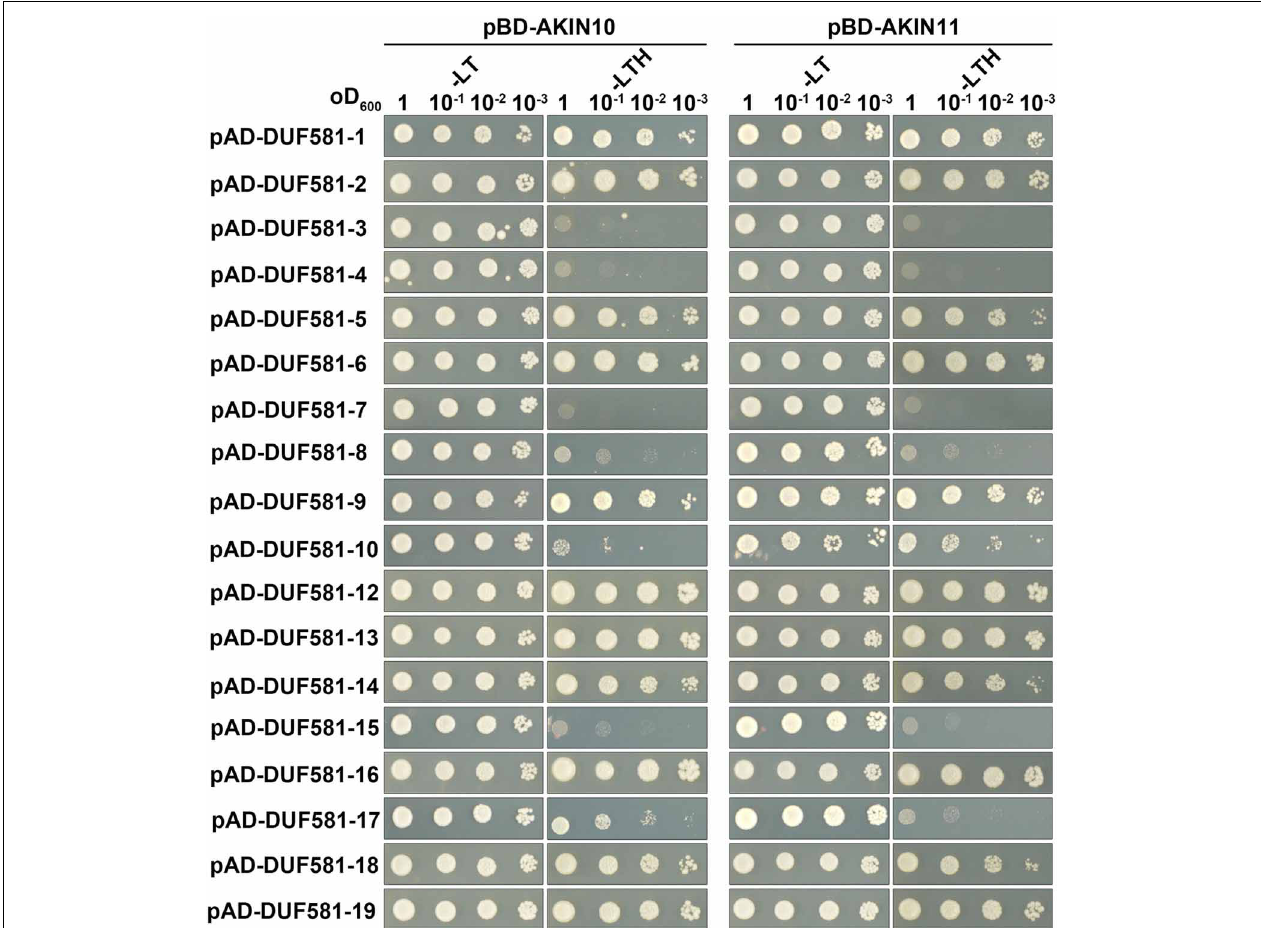
FIGURE 3 | Interaction of AKIN10 and 11 with Arabidopsis DUF581 proteins in yeast. Arabidopsis DUF581 proteins fused to the GAL4 DNA-binding domain (BD) were expressed in combination with either AKIN10 or AKIN11 fused to the GAL4 activation domain (AD) in yeast strain Y190.